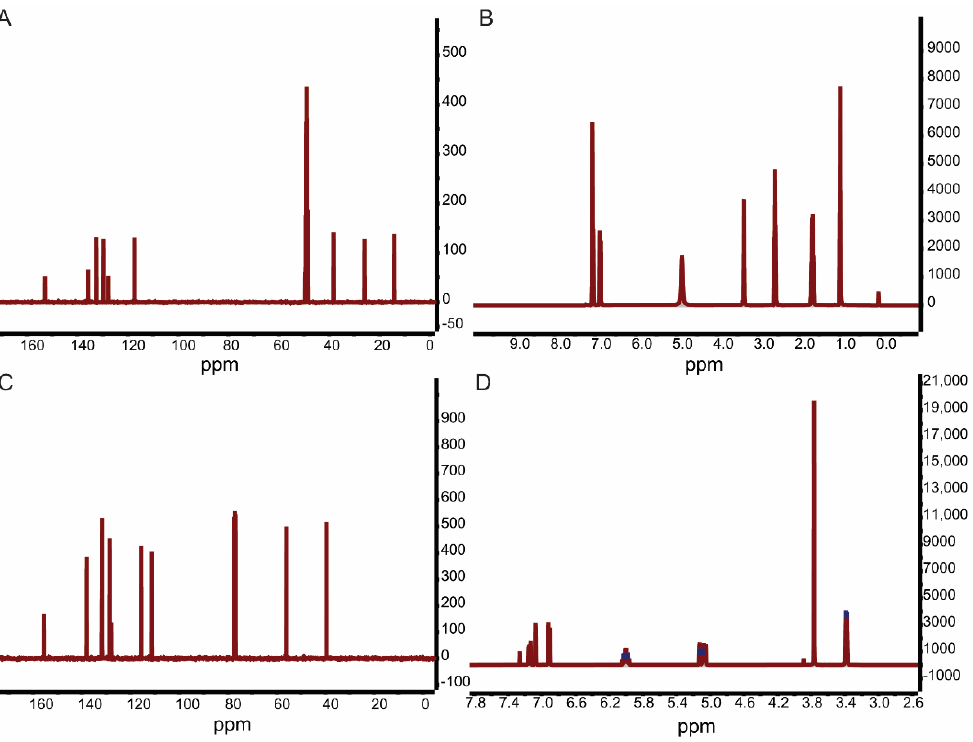
Figure 2. 13 C– and 1 H–NMR spectra of hydrogenated magnolol ( A , B ) and 2,2 ′ –dimethoxy-magnolol ( C , D ).